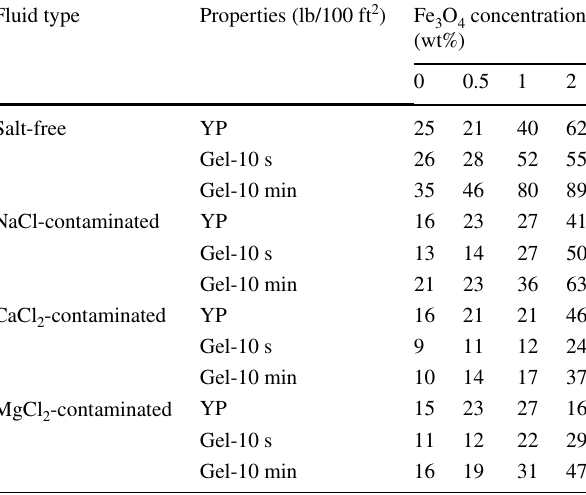
Table 2 Yield point and gel strength of all drilling